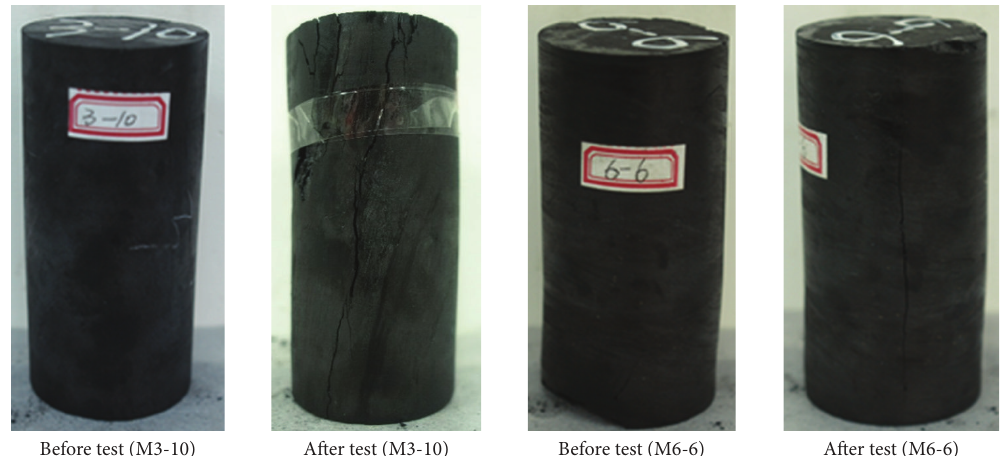
Figure 5: Images of typical specimens before and after uniaxial compression tests (M3-10 parallel specimen and M6-6 perpendicular